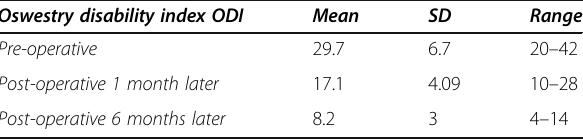
Table 4 Pre- and post-operative disability index score values of the included patients in our study Oswestry disability index ODI Mean SD